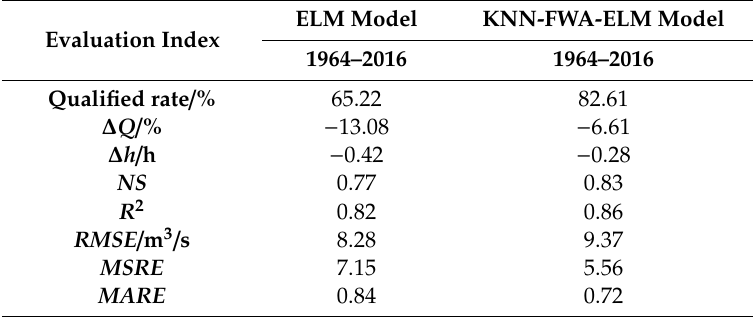
Table 5. Comparison of all flood simulation results between KNN-FWA-ELM and ELM